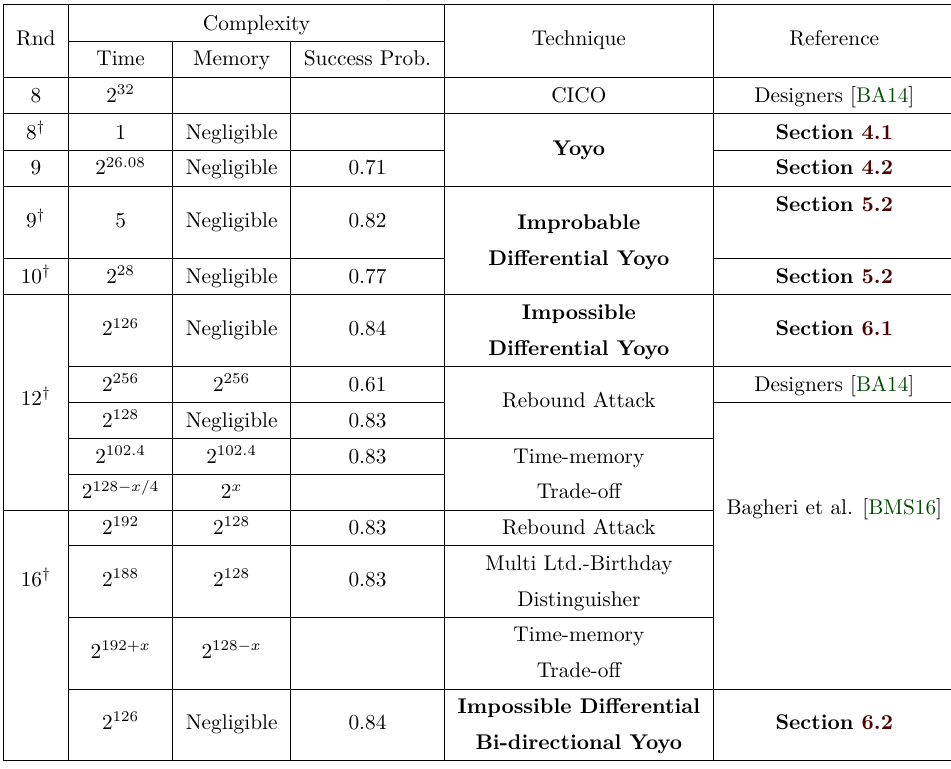
Table 1: Distinguishers on Round-Reduced